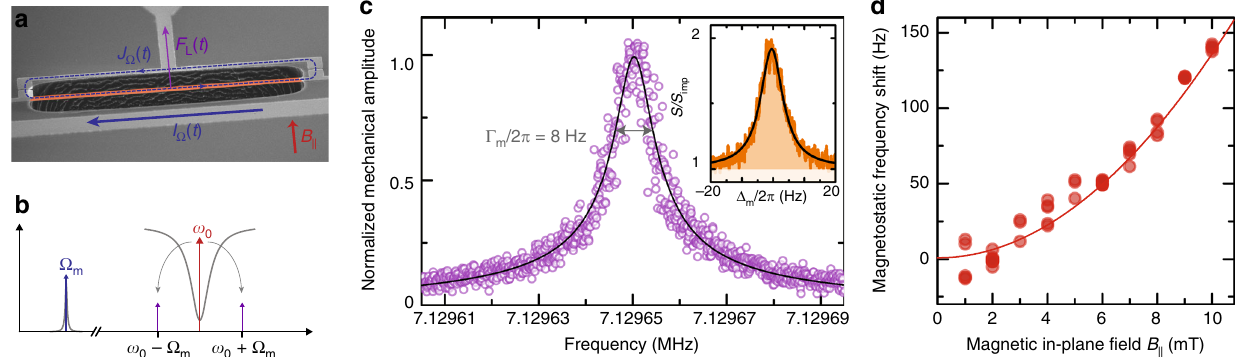
Fig. 2 Detection of mechanical motion using a superconducting SQUID cavity interferometer and observation of magnetostatic spring stiffening. a Schematic of coherently driving the mechanical oscillator by means of the Lorentz-force. The current sent through the bias line has a DC component to bias the SQUID with a fl ux Φ . This generates a circulating current J in the SQUID loop. In addition, an oscillating current is sent through the line with a b frequency close to the mechanical oscillator resonance frequency Ω (cid:3) Ω . Thus, the loop current through the mechanical beam oscillates correspondingly, m ð t Þ due to the presence of the magnetic in-plane fi eld B fl ux leading to an oscillating Lorentz-force F jj . The mechanical motion modulates the total magnetic L through the SQUID loop and hence the cavity resonance frequency. When a resonant coherent microwave tone is sent into the cavity, the mechanical oscillations generate sidebands at ω ¼ ω 0 ± Ω , cf. panel ( b ), which are observed to detect the mechanical motion. In ( c ), the down-converted sideband m signal is shown during a sweep of the excitation frequency Ω . Circles are data, the line is a Lorentzian fi t and both are normalized to the maximum of the fi t curve. The inset depicts the down-converted sideband thermal noise spectral density in absence of a coherent driving force, normalized to the background noise fl oor. Orange line are data, black line is a Lorentzian fi t. The contribution from the background noise is shaded in white and the contribution from the mechanical displacement noise in orange. The experimental settings for these measurements were B jj ¼ 9 mT and ∂ ω 0 = ∂ Φ (cid:5) 2 π ´ 20 MHz = Φ 0 . When increasing the magnetic in-plane fi eld, we observe a shift of the mechanical oscillator resonance frequency, shown in panel ( d ). This frequency shift is induced by a position-dependent contribution to the Lorentz-force and corresponds to a magnetostatic stiffening of the mechanical spring constant. The / B 2 circles are data and the line corresponds to a theoretical curve with δ Ω m